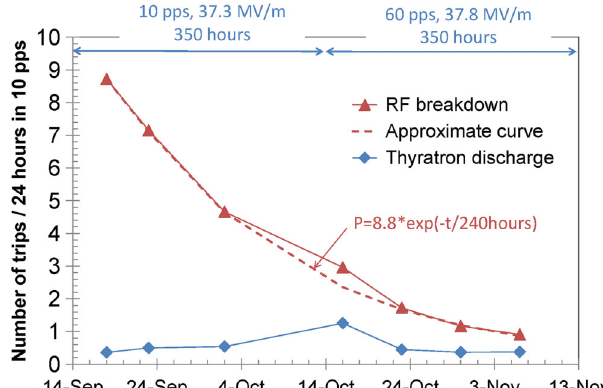
FIG. 15. Variation of the trip rate caused by rf breakdowns (red triangle) and early discharges of the thyratron (blue circle) during rf conditioning. The dashed line is an exponential fit to the rf breakdown trip rate.